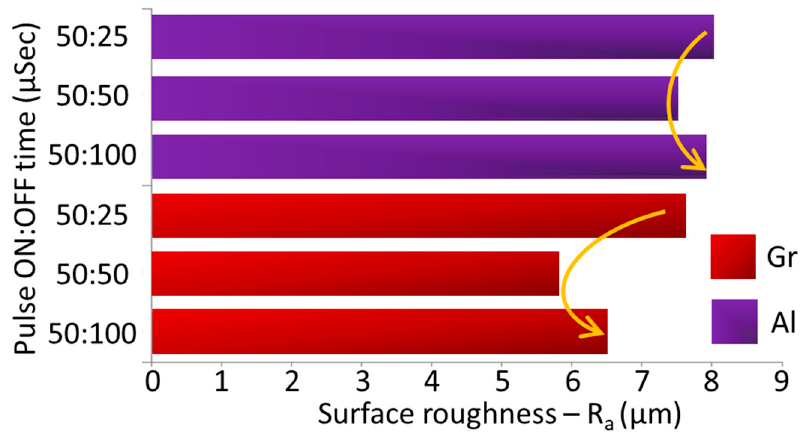
Figure 4. The parametric trend of surface roughness with kerosene as